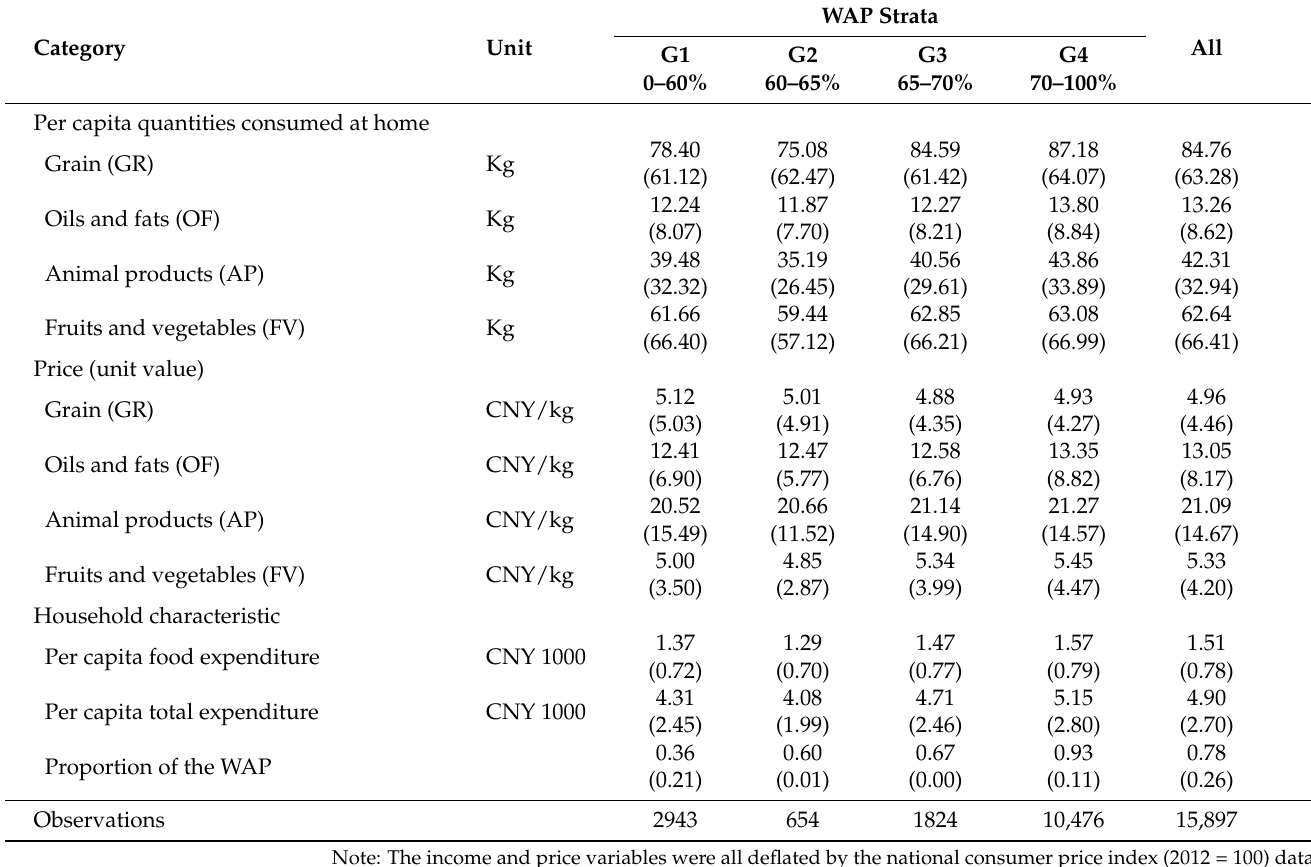
Table A1. Statistical description of major variables.